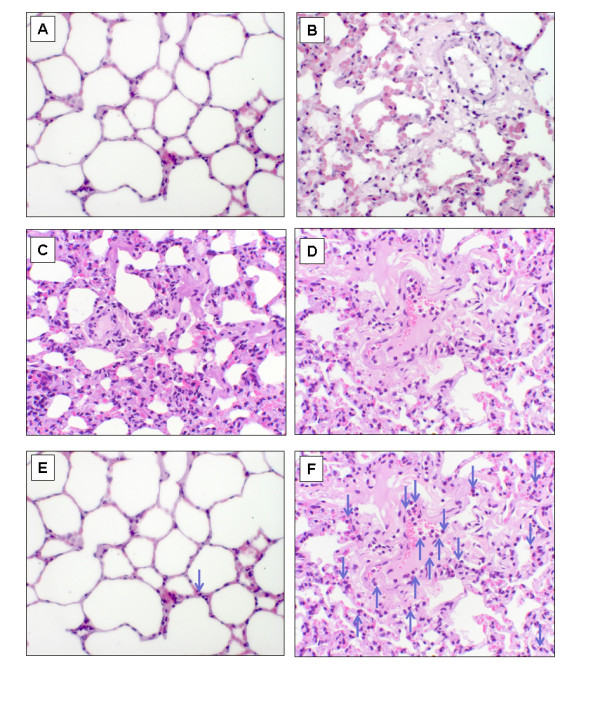
Representative histology. Representative haemotoxylin and eosin stained lung sections analysed histologically for pulmonary oedema. These range from no pulmonary oedema (A) through to mild (B), moderate (C) and severe (D) pulmonary oedema. Neutrophils were identified by morphological assessment and are indicated by the blue arrows (E and F). In contrast to sham sheep (E), there was widespread evidence of neutrophil infiltration in the lungs of LPS-stored sheep (F). LPS, lipopolysaccharide.